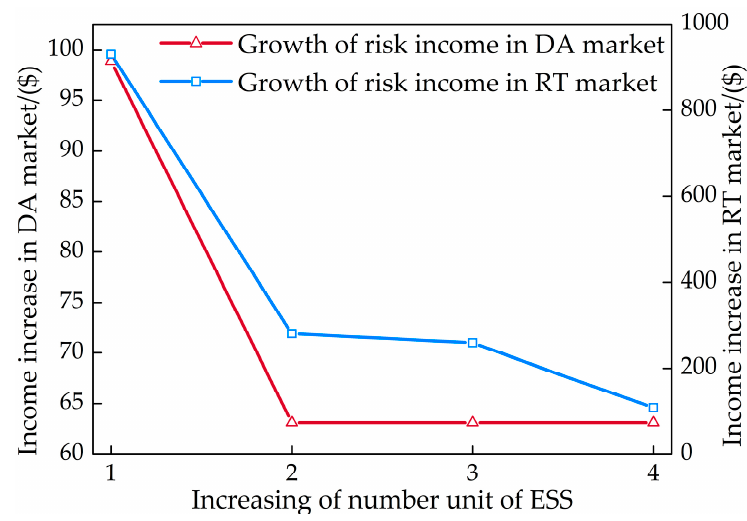
Figure 13. Risk income of the VPP with different ESS units.